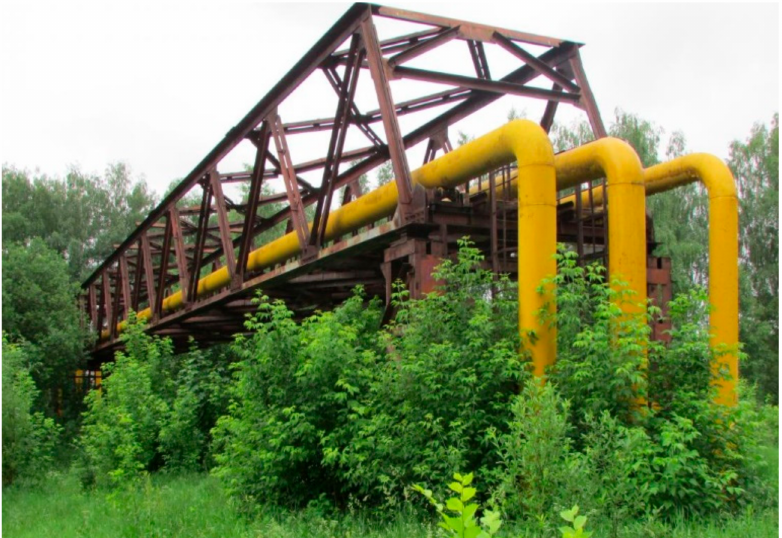
Figure 1. Gas pipeline overpass through an obstacle. Copyrighted by